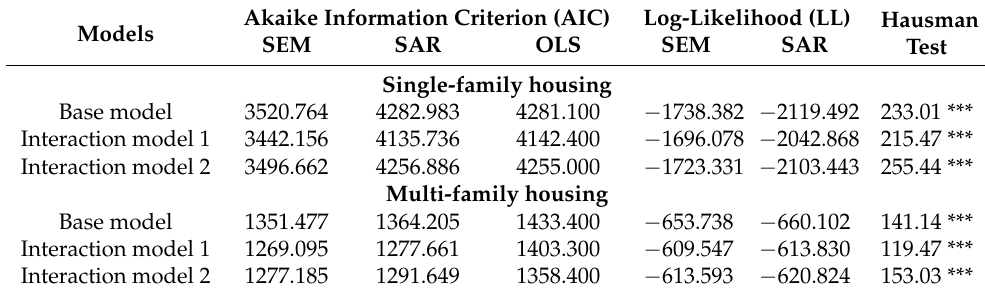
Table 4. Results of final model